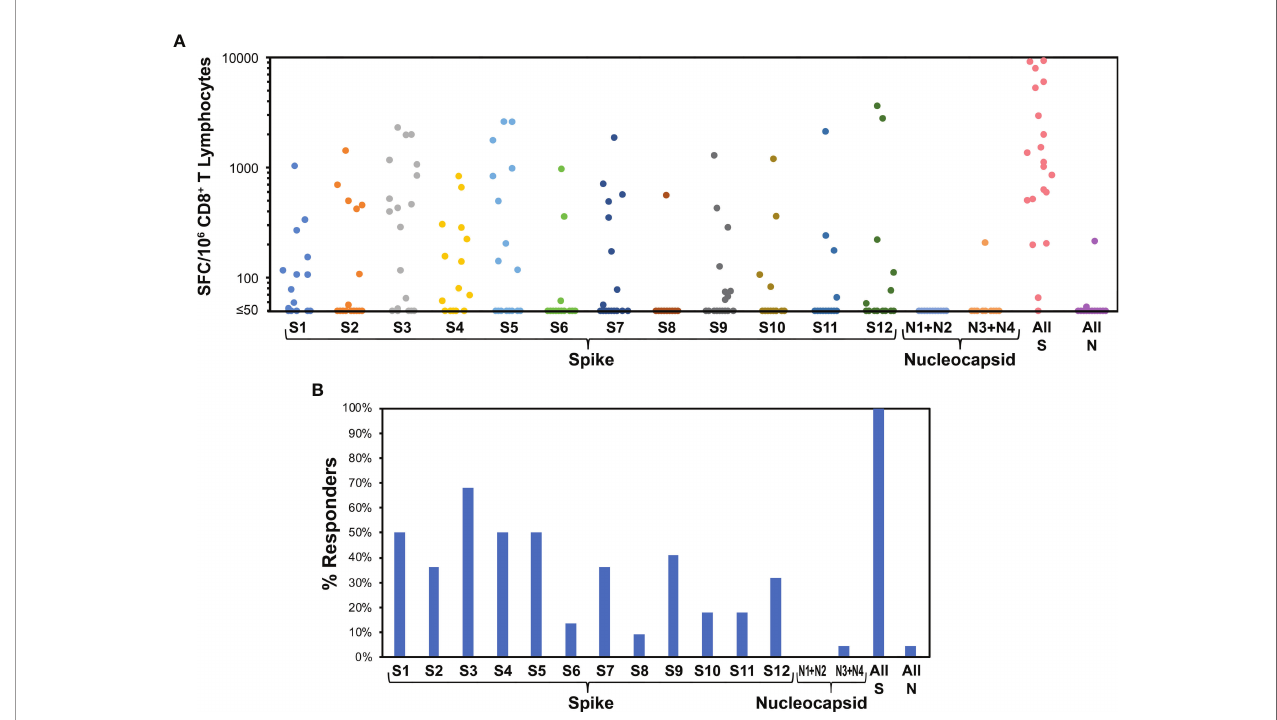
FIGURE 5 | Spike targeting after vaccination of persons without prior SARS-CoV-2 infection is broadly distributed. 22 persons without a history of SARS-CoV-2 infection were monitored for responses against spike and nucleocapsid (negative control) by ELISpot assay after vaccination with BNT162b2 (15 persons) or mRNA- 1273 (7 persons). Responses were evaluated a mean of 11.3 days after the fi rst vaccine dose (range 8 to 16 days). (A) Frequencies of responses against each pool are plotted for each participant. The mean total response against spike was 2,463 SFC/million CD8 + T cells. (B) Percentages of persons responding against each pool are plotted. Targeting of spike was an average of 4.2 pools per person. Response against pools S4 and S5, comprising the receptor binding domain of spike, was an average 1.0 peptide pools per person.